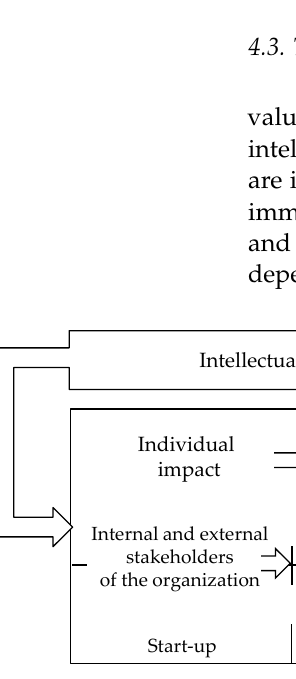
Figure 9. The impact of the entity on the dependent external stakeholders of the organization. Source: author’s own development.